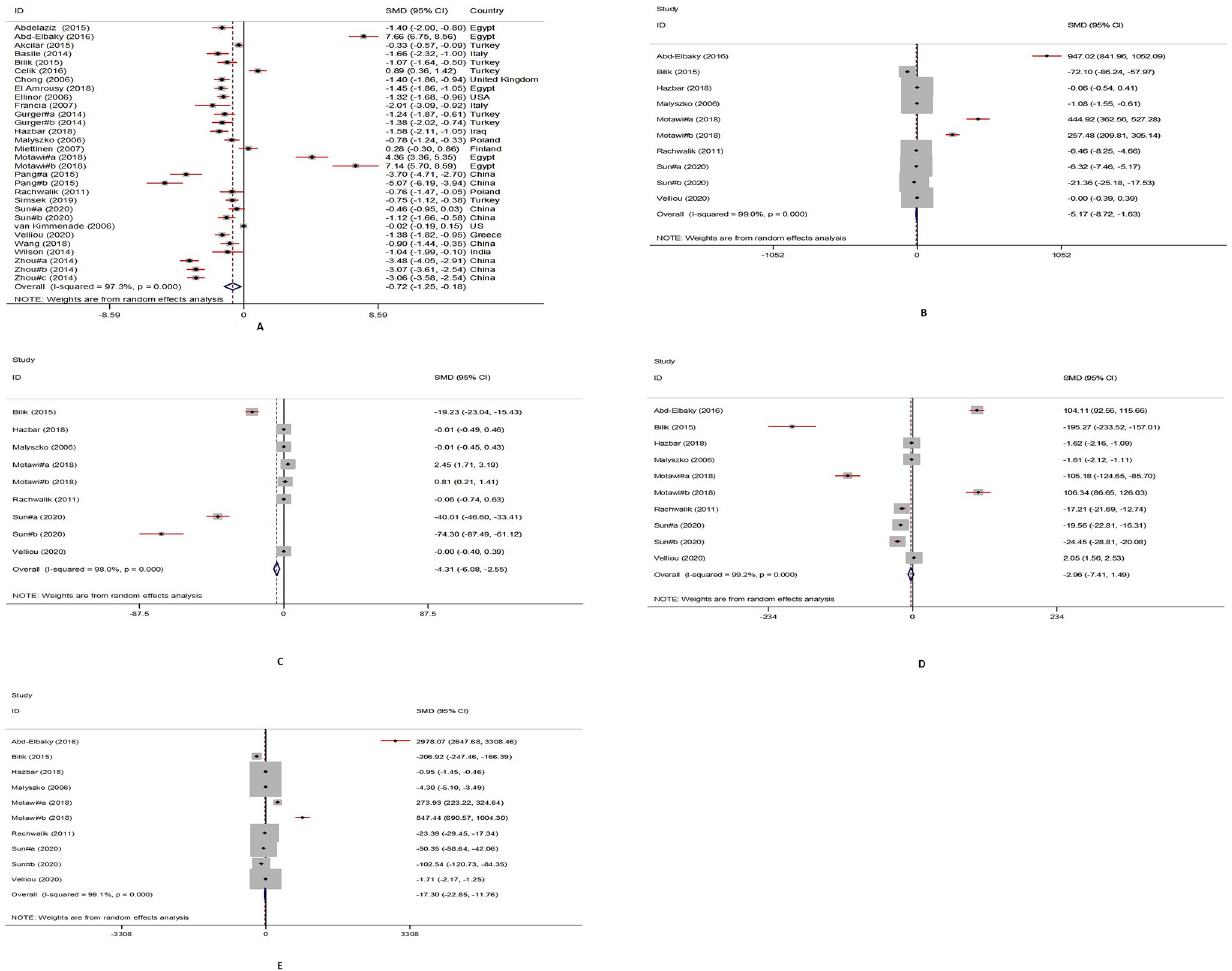
Fig 2. The forest plots of pooled estimates of standardized mean differences of circulating apelin (A), apelin/HDL-c (B), apelin/LDL-c (C), apelin/ triglycerides (D), and apelin/total cholesterol (E) levels between cases with CVDs and controls.